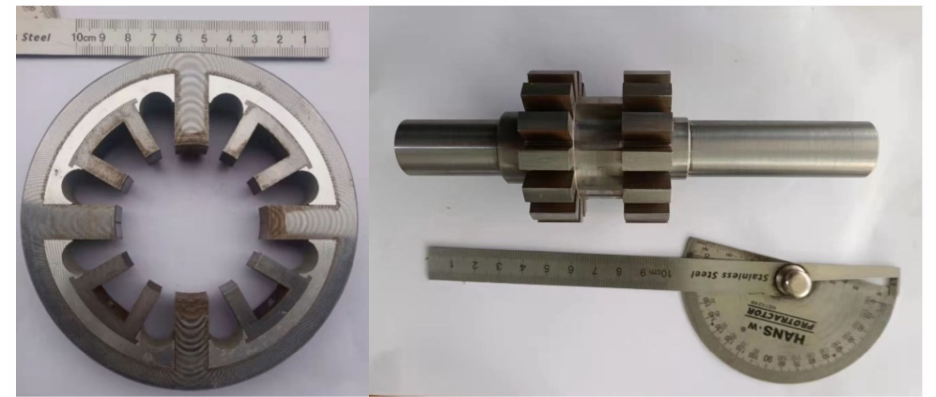
Figure 7. The prototype.